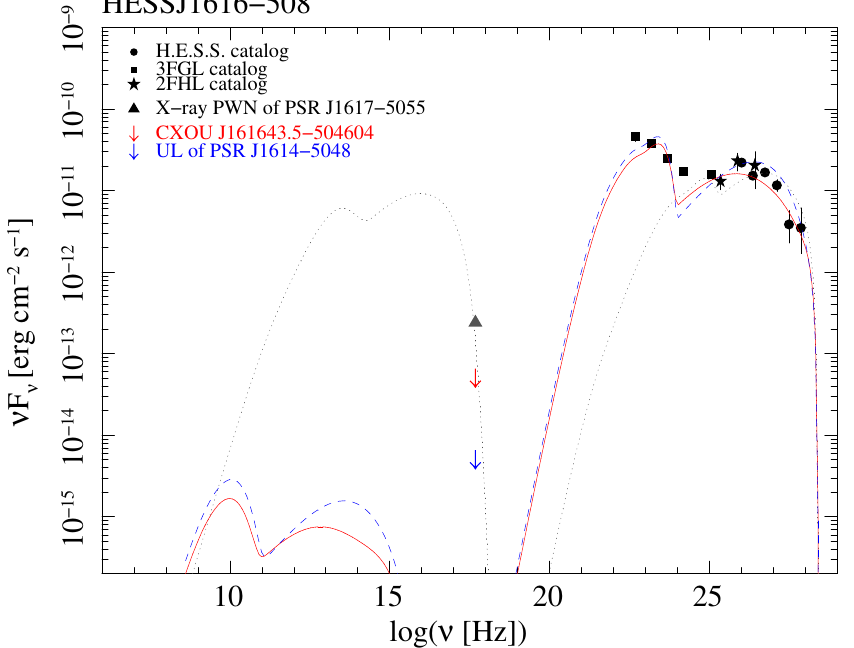
Figure 2. Spectral energy distribution of HESS J1616-508 with the TeV gamma ray spectrum from the H.E.S.S. catalog [76] (circles), GeV spectrum of 3FGL J1616.2-5054e (squares) from the 3FGL catalog [73], the 2FHL catalog spectral points of 2FHL J1616.2-5054e (stars) [74] . The single X-ray measurement of the X-ray PWN around PSR J1617-5055 by [70] is shown as triangle, the upper limit based on the detection of the X-ray source CXOUJ 161643.5–504604 [71] is shown as a red arrow, and the upper limit of PSR J1614-5048 [71] is shown as a blue arrow. The time-dependent PWN models are shown as described in the text. The dotted line represents the first scenario (i.e., connecting HESS J1616-508 to the X-ray PWN powered by PSR J1617-5055), the dashed line HESS J1616-508 represents the predicted emission when the object is considered as a PWN powered by PSR J1614-5048, and the solid line represents the gamma ray source as a PWN powered by the candidate pulsar CXOUJ 161643.5–504604, as described in the